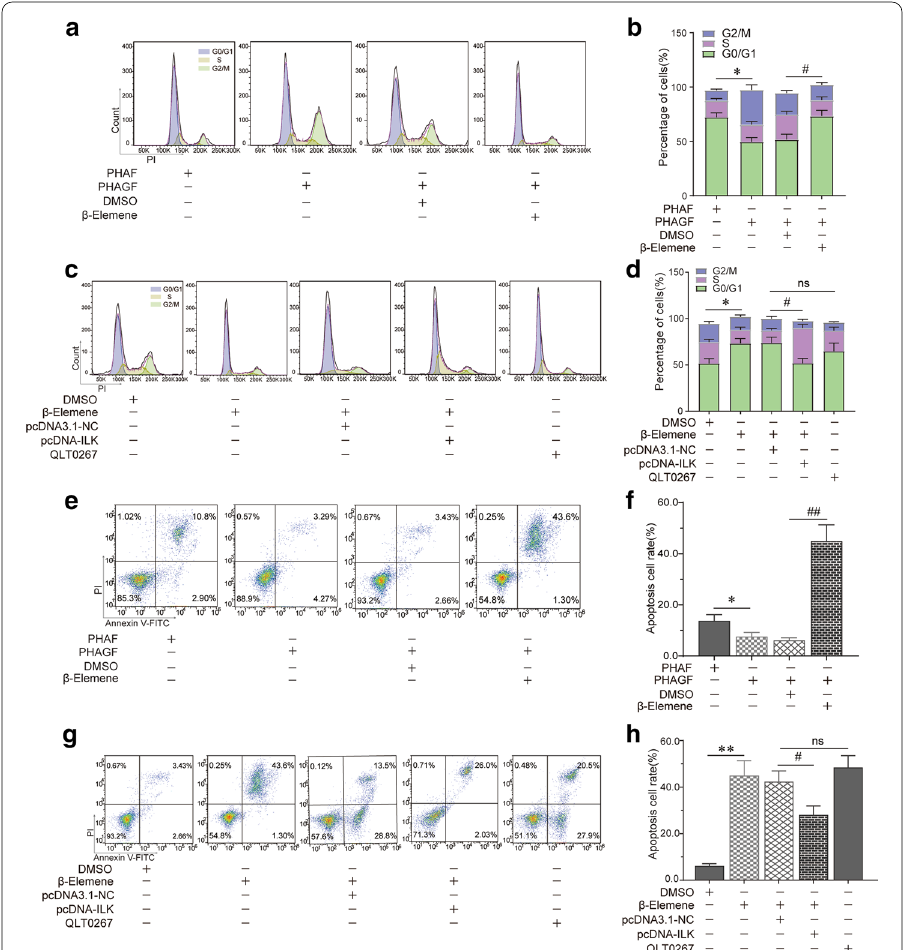
Fig. 3 β-Elemene induced PHAGF G0/G1-phase arrest and apoptosis by suppressing ILK/Akt pathway. a – d Cell cycle distributions in PHAF, PHAGF and PHAGF under indicated treatments were analyzed by flow cytometry, and their corresponding statistical graphs were presented (comparing the rate of cell-cycle arrest in G0/G1-phase). e – h Apoptosis in PHAF, PHAGF and PHAGF under indicated treatments were analyzed by flow cytometry, and their corresponding statistical graphs were presented (comparing the relative amount of the early apoptosis plus late apoptosis). * P < 0.05; ** P < 0.01; # P < 0.05; ## P < 0.01; ns not